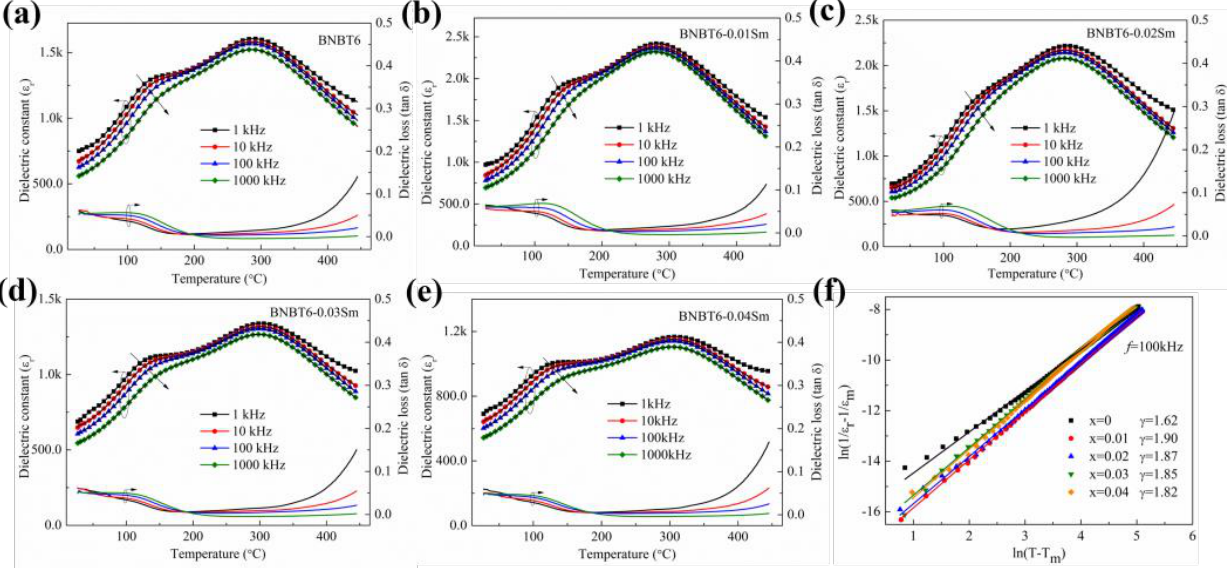
Figure 3. Temperature dependence of dielectric constant and dielectric loss of porous BNBT6- x Sm ceramics at ( a ) x = 0, ( b ) x = 0.01, ( c ) x = 0.02, ( d ) x = 0.03, and ( e ) x = 0.04. ( f ) Plots of ln (1/ ε r − 1/ ε m ) as a function of ln ( T − T m ) for porous BNBT6- x Sm ceramics at 100 kHz.